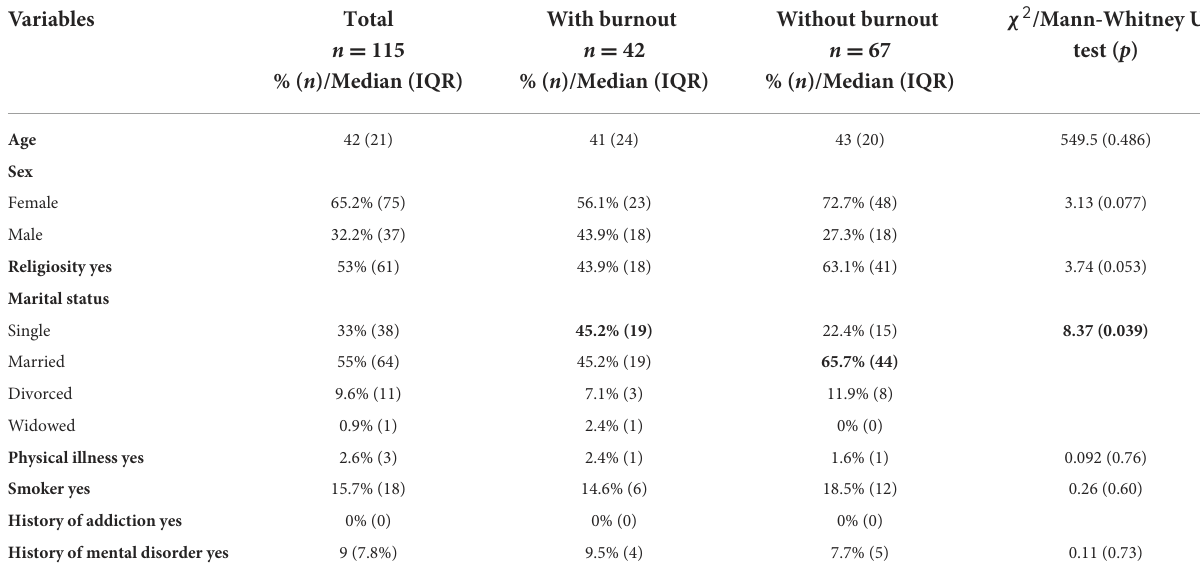
TABLE 1 Sociodemographic characteristics of the study participants according to the presence of burnout and differences between the study cohort groups.